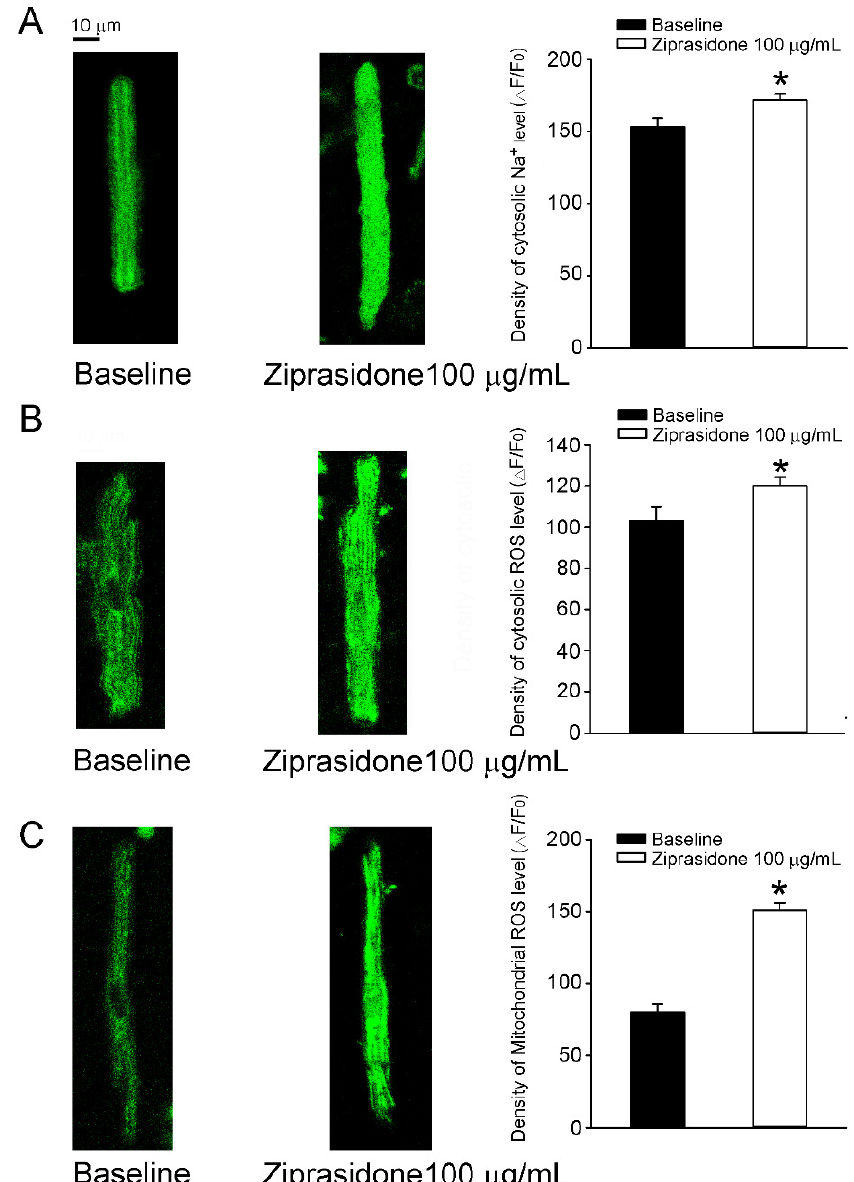
Figure 5. Cytosolic Na + level and oxidative stress in atrial myocytes treated with or without ziprasi- done. ( A ): Fluorescent images of cytosolic Na + levels in atrial myocytes treated with or without ziprasidone and mean data (baseline group n = 26/3, ziprasidone group n = 37/3; * p < 0.05). ( B ): Fluorescent images of cytosolic levels of reactive oxygen species (ROS) in atrial myocytes treated with or without ziprasidone and mean data (baseline group n = 11/3, ziprasidone group n = 29/3; * p < 0.05). ( C ). Fluorescent images of mitochondrial ROS levels in atrial myocytes treated with or without ziprasidone and mean data (baseline group n = 26/3, ziprasidone group n = 32/3; * p < 0.05).